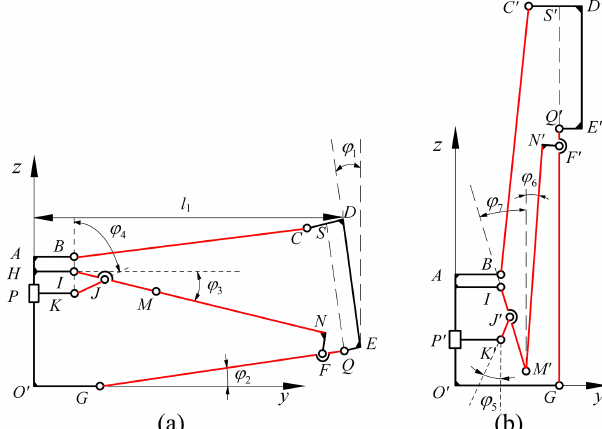
Figure 7. Schematic diagram of a parameter calculation model. (a) Fully deployed. (b) Fully